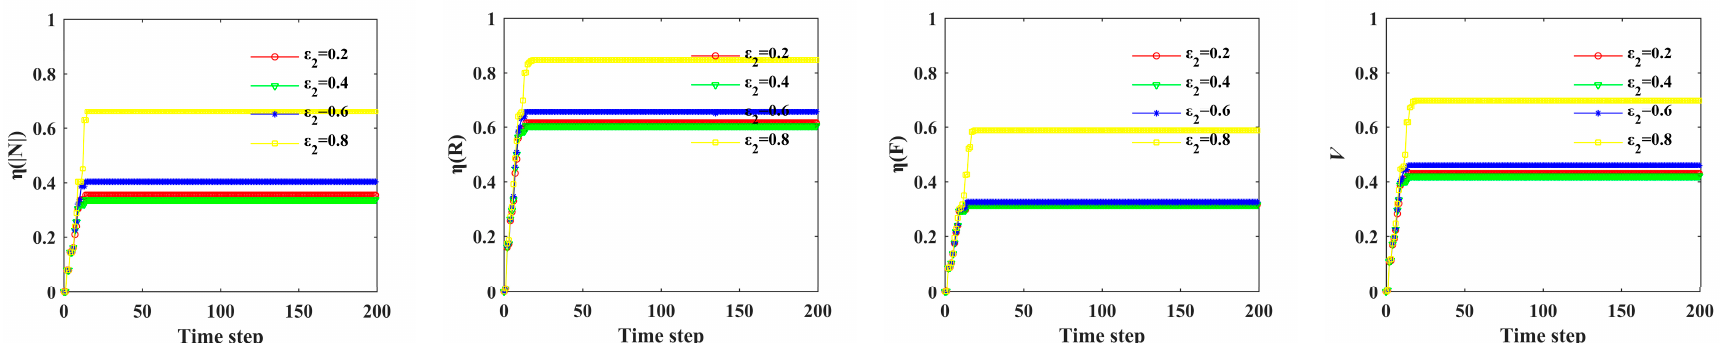
Figure 10. Cascading failures of Bus–Metro CBN under different node coupling strengths. (a) – (c) show the loss ratio of node scale in the maximum connected subgraph, the network efficiency and the passenger flow with time under different node coupling strengths, respectively. (d) shows the change of network vulnerability with time under different node coupling strengths. Note: in these scenarios, s = 1.0, α = 0.3, ε 2 = 0.2, λ 1 = λ 2 = λ 3 = 1 . 3